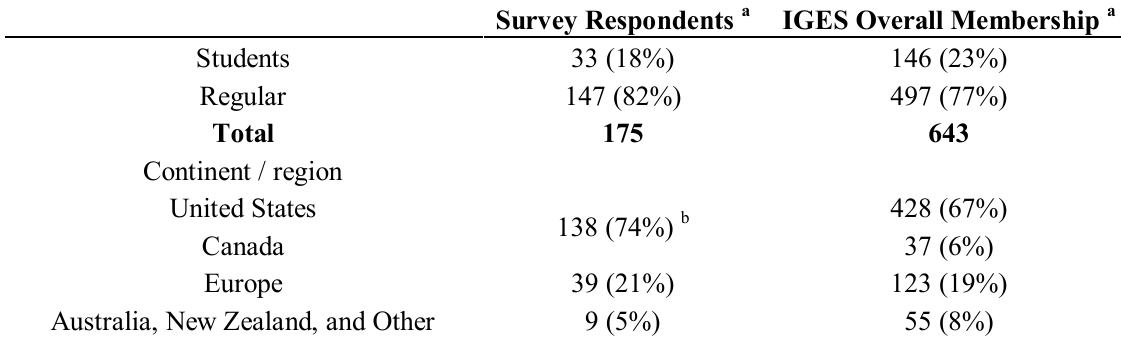
Table 1. Demographics of survey respondents compared to overall IGES membership.